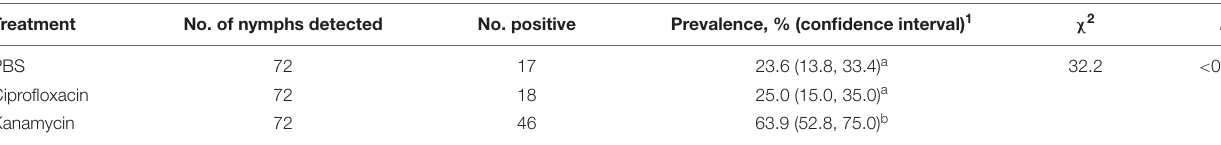
TABLE 2 | Prevalence of B. microti in R. haemaphysaloides nymphs from different treatment groups. Treatment No. of nymphs